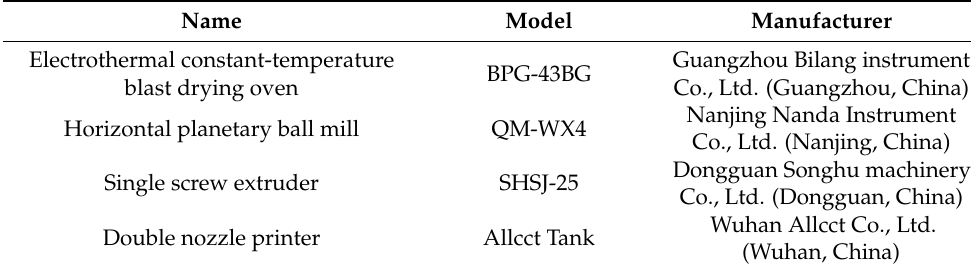
Table 2. Experimental instruments.